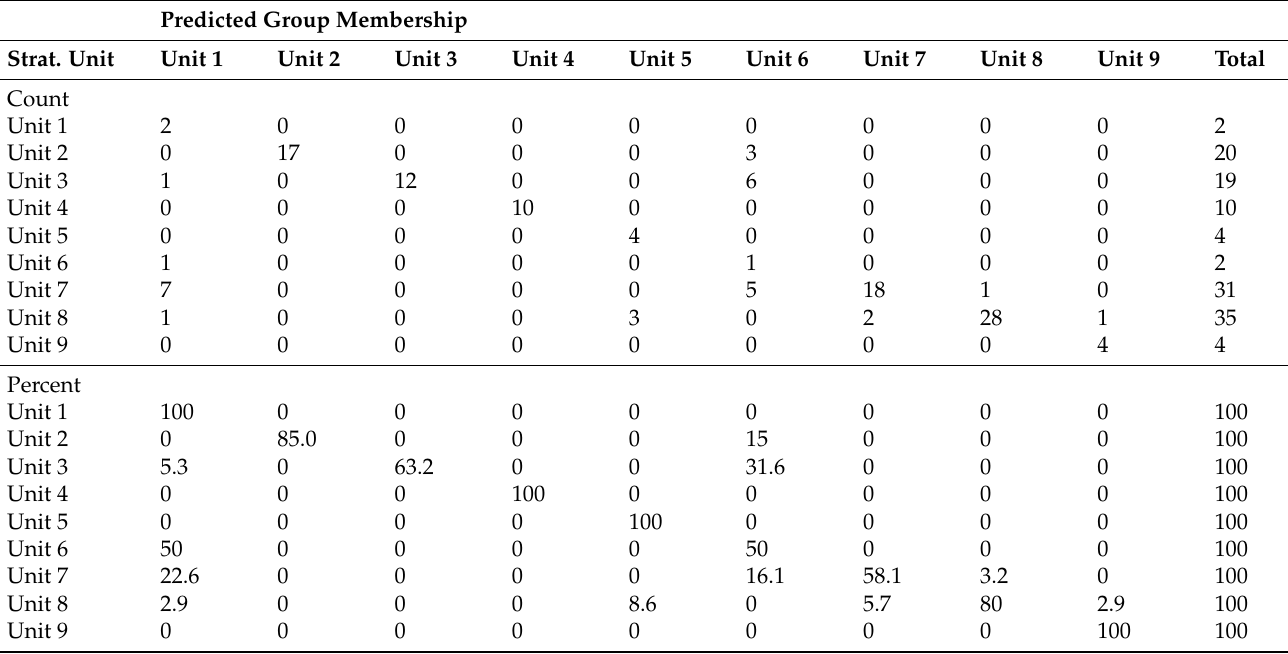
Table 6. Summary of samples from chemostratigraphic units in both legacy and precolonial deposits that were correctly classified by discriminant analysis when the data were